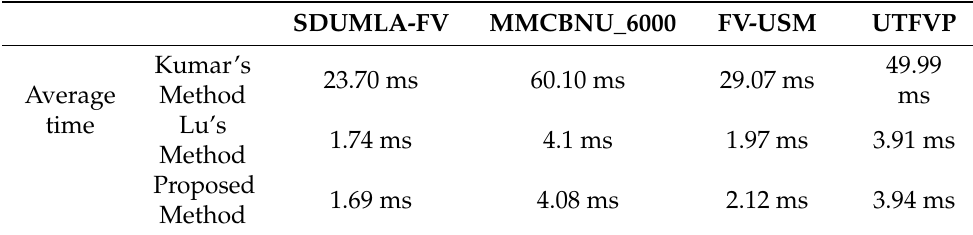
Table 2. Comparisons of the time consumption using different finger area segmentation